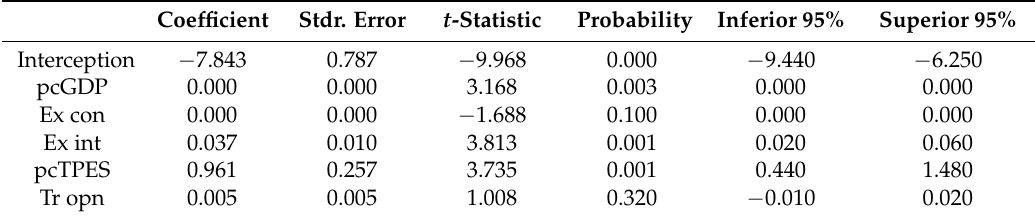
Table 7. Regression of ffCO 2 emissions and